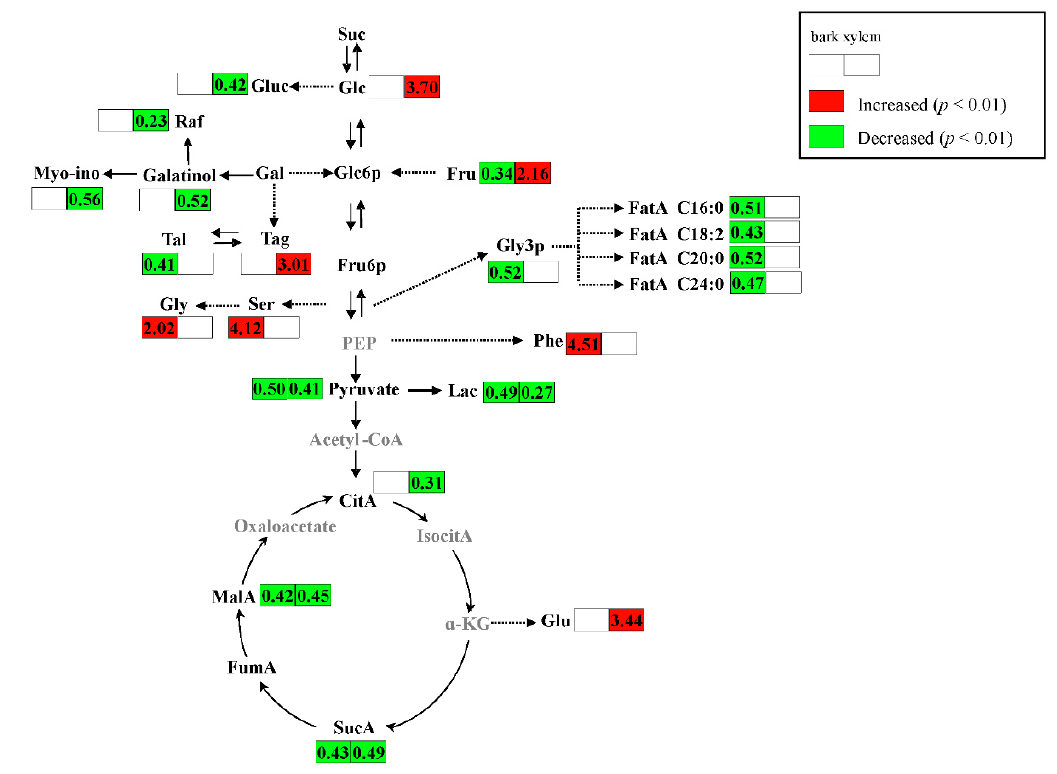
Figure 5. Level changes of metabolites in the main metabolic pathways. Values in the boxes were ratios of peak intensity of metabolites in A. germari infected samples to those in mock-infected samples. Colors of red and green represented elevated and decreased levels of a metabolite in A. germari infected samples compared with mock-infected samples, respectively. Extended metabolites were marked with gray color. α -KG, alpha-ketoglutarate; CitA, citrate; FatA C16:0, palmitic acid; FatA C18:2, linoleic acid; FatA C20:0, arachidic acid; FatA C24:0, lignoceric acid; Fru, fructose; Fru6P, fructose 6-phosphate; FumA, fumaric acid; Gal, galactose; Glc, glucose; Gluc, Gluconic acid; Glc6P, glucose-6-phosphate; Glu, glutamate; Gly, glycine; Gly3P, glycerol-3-phosphate; IsocitA, isocitric acid; Lac, lactic acid; MalA, malic acid; Myo-ino, Myo-inositol; PEP, phosphoenol-pyruvate; Phe, phenylalanine; Raf, raffinose; Ser, serine; Suc, sucrose; SucA, succinate; Tag, Tagatose; Tal, Talose. Solid and dashed arrows indicated single and multiple enzymatic conversions, respectively.